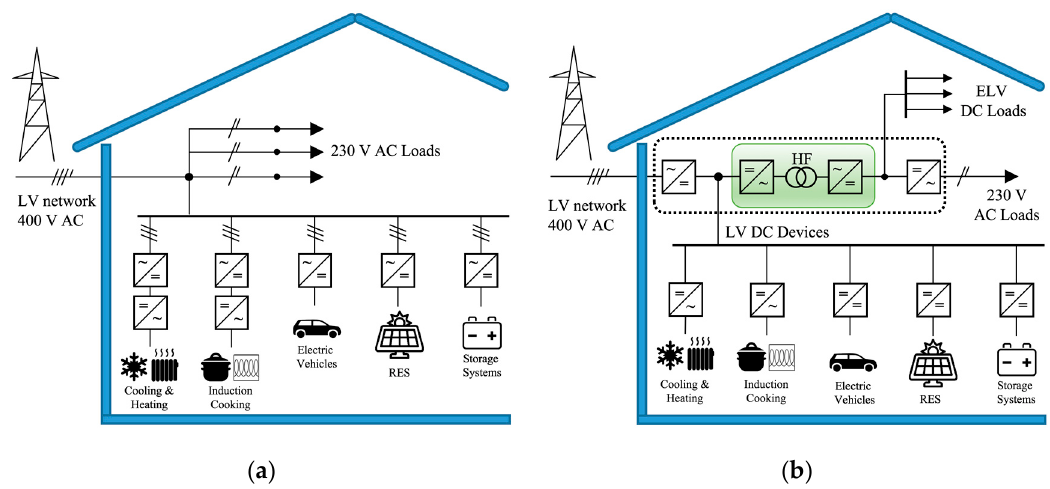
Figure 1. Electric schemes for a residential building hosting a huge penetration of electric devices: ( a ) Traditional network architecture based on AC internal distribution; ( b ) Conceptual representation of the innovative AC/DC topology, with three available voltage levels (according to appliance rated power and safety requirements) and partial galvanic insulation (realized through the DC/DC module of the solid state transformer (SST)).